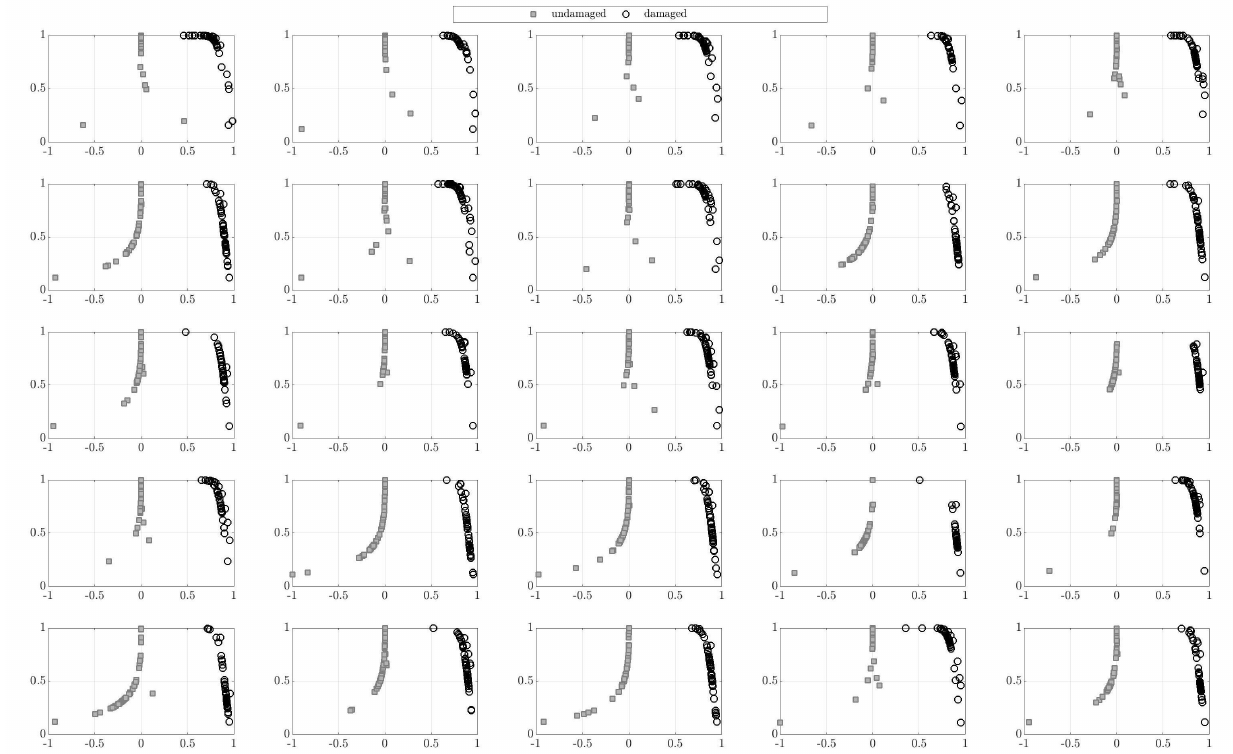
Figure 6. Classification of the damaged and undamaged components using the kernel